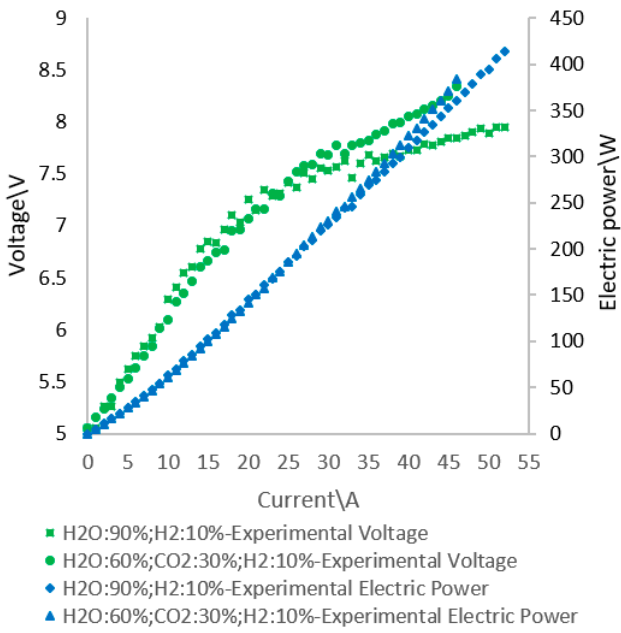
Figure 5. Comparison between the experimental voltage-current data and electric power-current data of the SOE stack fed by the gas mixture of steam and H 2 and air and by the gas mixture of steam, CO 2 and H 2 and air.